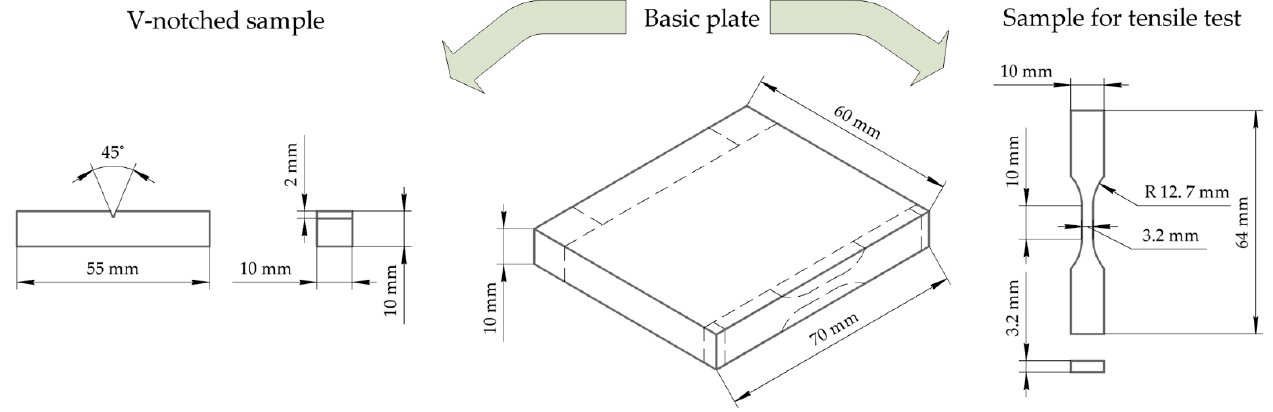
Figure 1. A schematic representation of the hot-pressed plate and cut test samples.